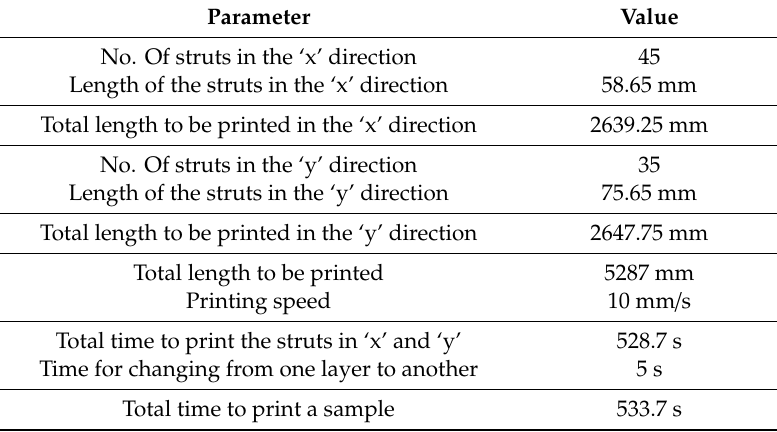
Table 1. Case study: Calculation of the total time to print a mesh in the new proposed